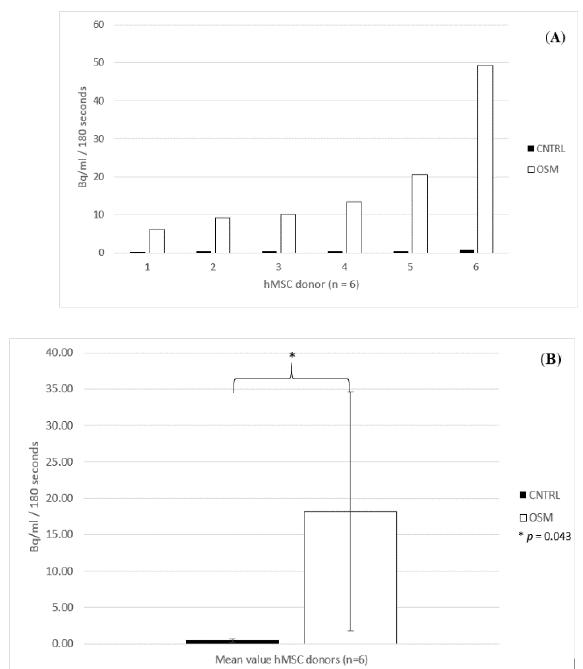
Figure 1. Exemplary µ-PET image of two dishes of one donor. Upper row of the dish was treated using osteogenic medium, while the lower row the dish was treated with control media. Blue and green outlines (indicated by white arrows) defining the regions of interest around the two dishes in axial, coronary and sagittal views.